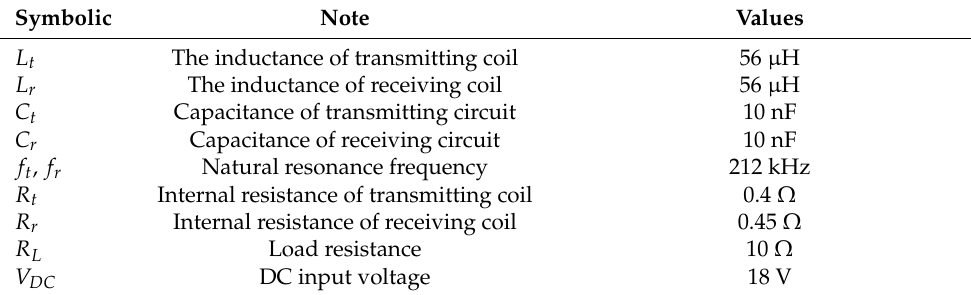
Table 1. The experimental parameters.